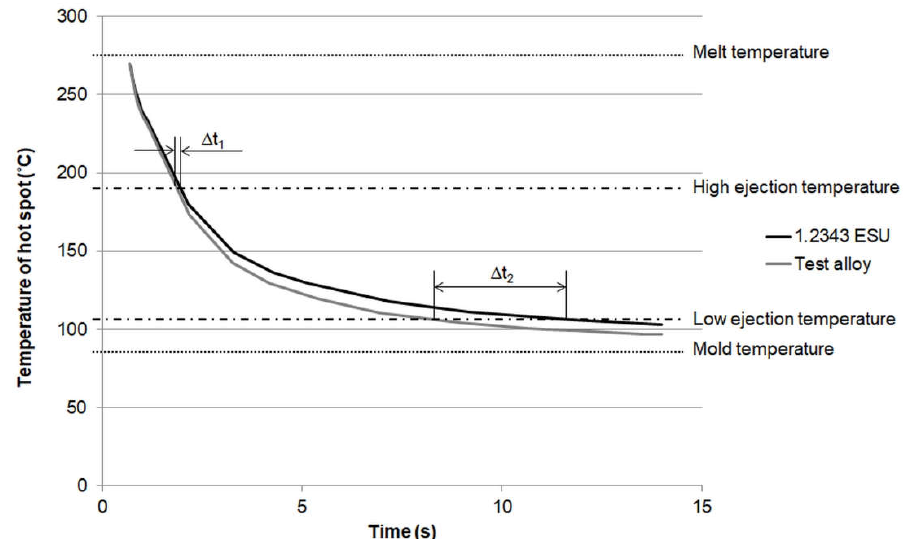
Figure 8. Temperature of the hot spot of the box as a function of time for the ABS/PC grade and a